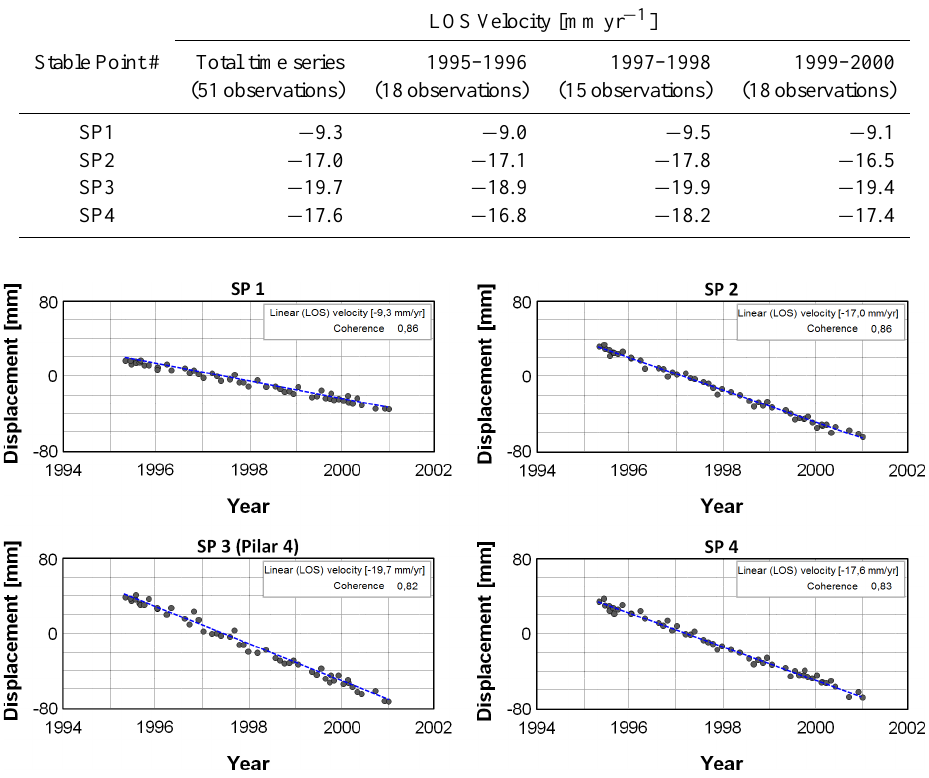
Fig. 8. Displacement time series from the four stable points (SP) resolved by ERS descending observation in the bridge structure (see Fig. 6b for location). The numbering was attributed from left to right. The deformation history is in the LOS direction. Fitted linear regression is also represented. Figure generated by viStaMPS (Sousa et al.,